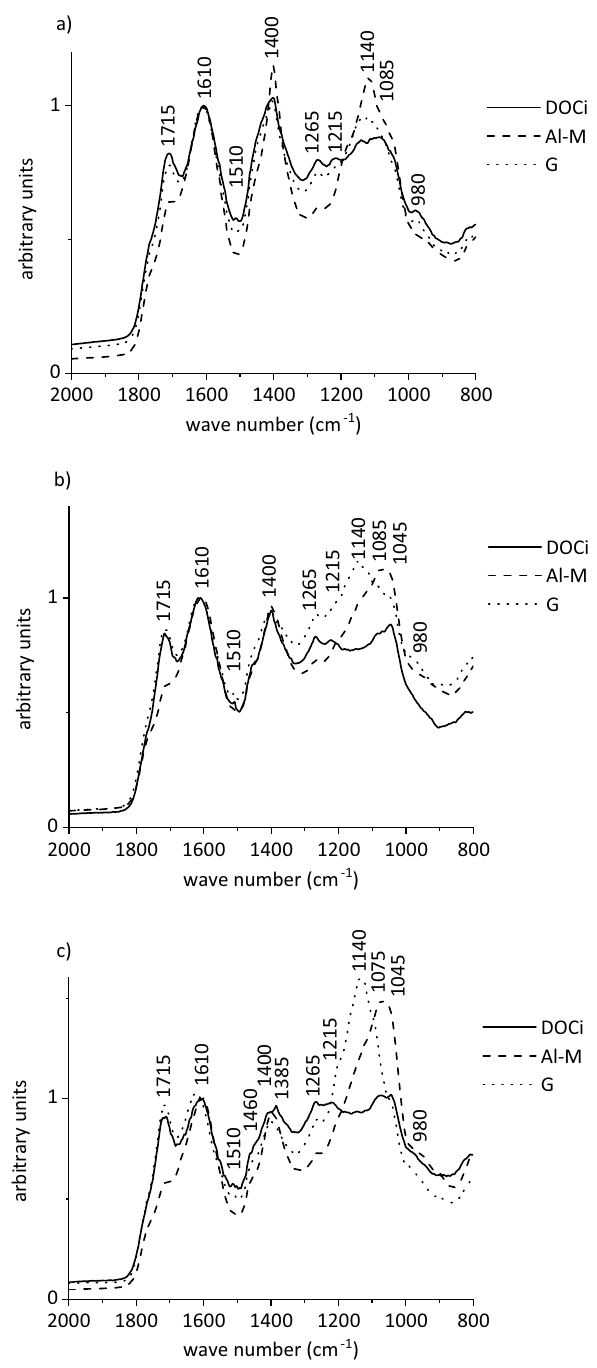
Figure 4. Exemplary partial diffuse reflectance infrared Fourier transform spectra of freeze-dried composite solutions taken after ( a ) 1–10, ( b ) 11–20, and ( c ) 31–40 pore volumes of the slow run prior to adsorption (DOCi) and of filtrates after adsorption experiments with Al-montmorillonite (Al-M) and goethite (G). All spectra were normalised to the band at 1610 cm −1